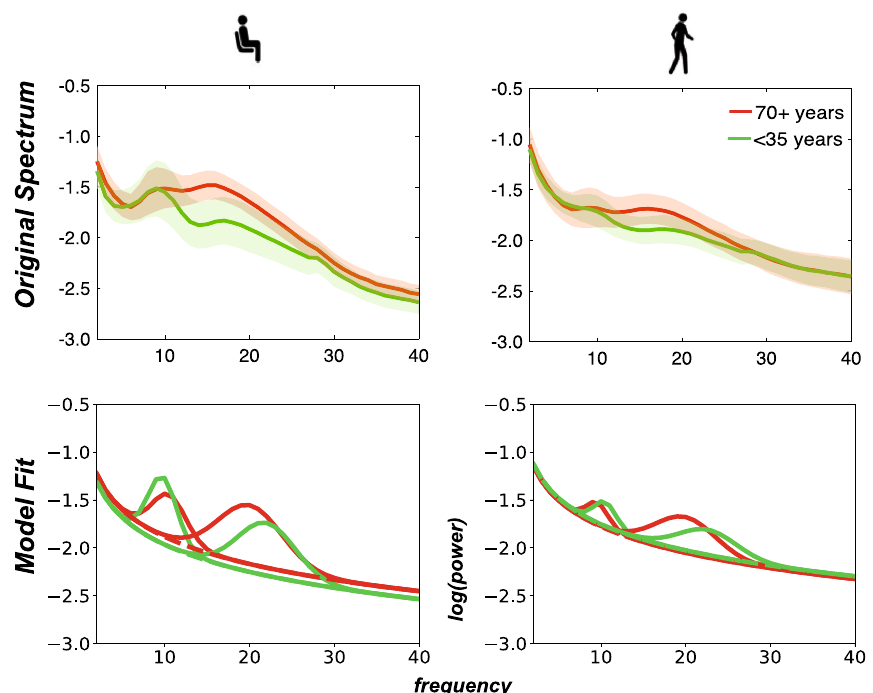
Figure 3. Upper row: Mean PSD traces over both centrolateral clusters from 4 to 40 Hz during sitting (left) and walking (right). A 95% confidence interval for each group is indicated by the surrounding envelope in the corresponding color. Lower row: Mean model fit of the spectra obtained by the FOOOF-algorithm 23 .The dashed line is the fit of the aperiodic component. Mean traces for older participants are red and for younger participants they are green in all four plots.